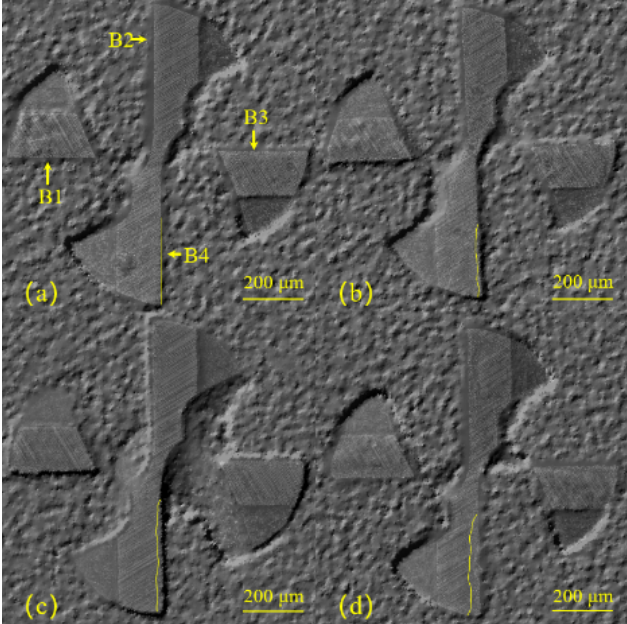
Figure 7. Schematic diagram of wear area of micro-milling cutter under different wear states.